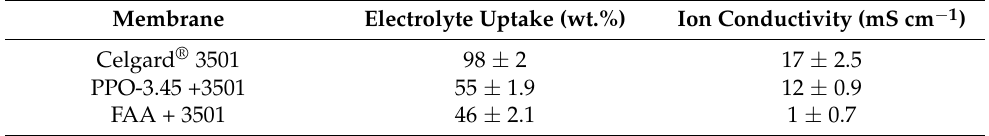
Table 4. Characterization of the prepared membranes: electrolyte and ion conductivity.